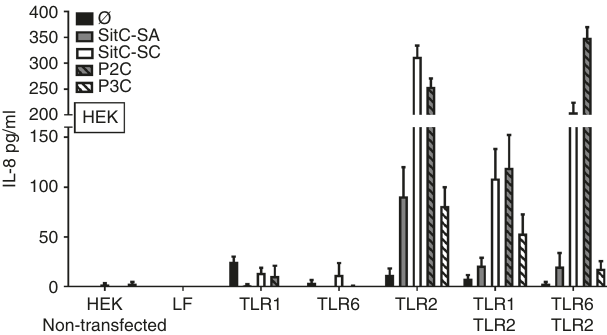
Fig. 5 Cytokine response of HEK cells transfected with TLR1, 2, and 6 receptor cDNA to various TLR2 ligands. To assess differential recognition of di- and triacylated Lpp by TLR1/TLR2 and TLR6/TLR2 heterodimers in HEK293 cells, HEK293 cells were transfected with 90 ng of TLR1 or TLR6 or 100 ng of TLR2 cDNA alone or with low TLR2 cDNA (10 ng) together with 90 ng of TLR1 or TLR6, respectively. In all conditions, cells were either unstimulated (Ø), stimulated with 100 ng of SitC puri fi ed from S. carnosus (SitC-SC) or from S. aureus (SitC-SA), or with 100 ng of synthetic Lpp Pam 2 CSK 4 (P2C) and Pam 3 CSK 4 (P3C), respectively. IL-8 secretion was quanti fi ed by ELISA 18 h after stimulation and compared with untransfected HEK293 cells (left) or lipofectamine only (LF) as controls. The diagram shows the results obtained in three representative experiments performed in